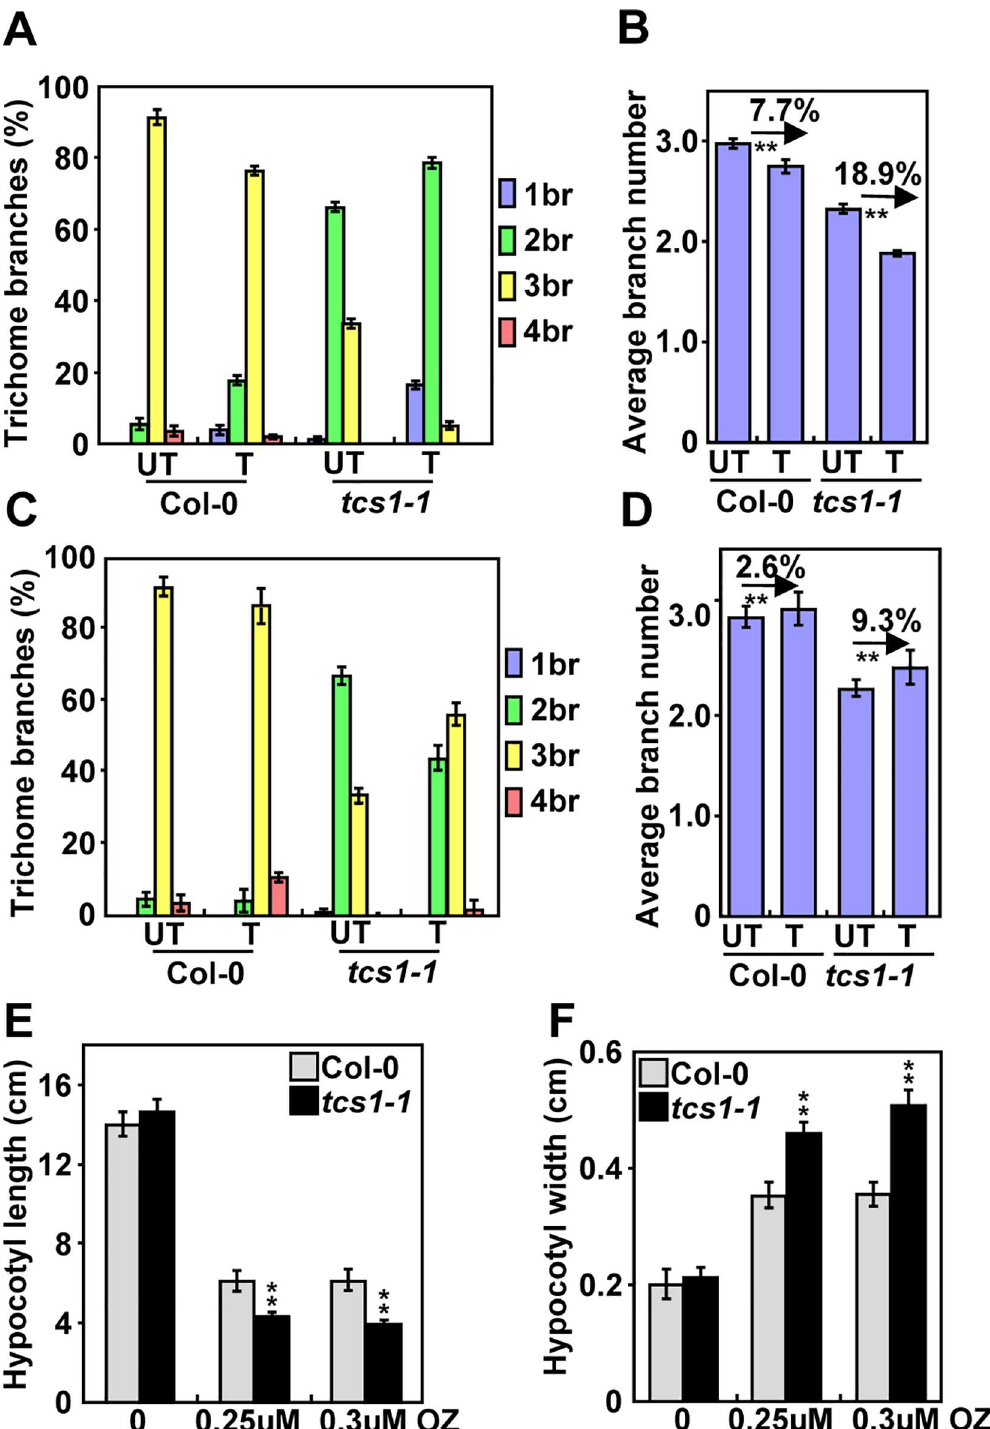
Fig 2. Trichomes and hypocotyls of tcs1-1 are hypersensitive to the microtubule-disrupting drug oryzalin and the microtubule-stabilizing drug paclitaxel. (A) Trichome branch distributionof Col-0 and tcs1-1 treated with (T) or without (UT) 20 μ M oryzalin for 2 hours. The branch number of Col-0 and tcs1-1 trichomes was examinedafter a 10-day recovery on ½ MS medium. (B) The average number of Col-0 and tcs1-1 trichome branches treated with (T) or without (UT) 20 μ M oryzalin for 2 hours. The branch number of Col-0 and tcs1-1 trichomes was examinedafter a 10-day recovery on ½ MS medium. (C) Trichome branch distribution of Col-0